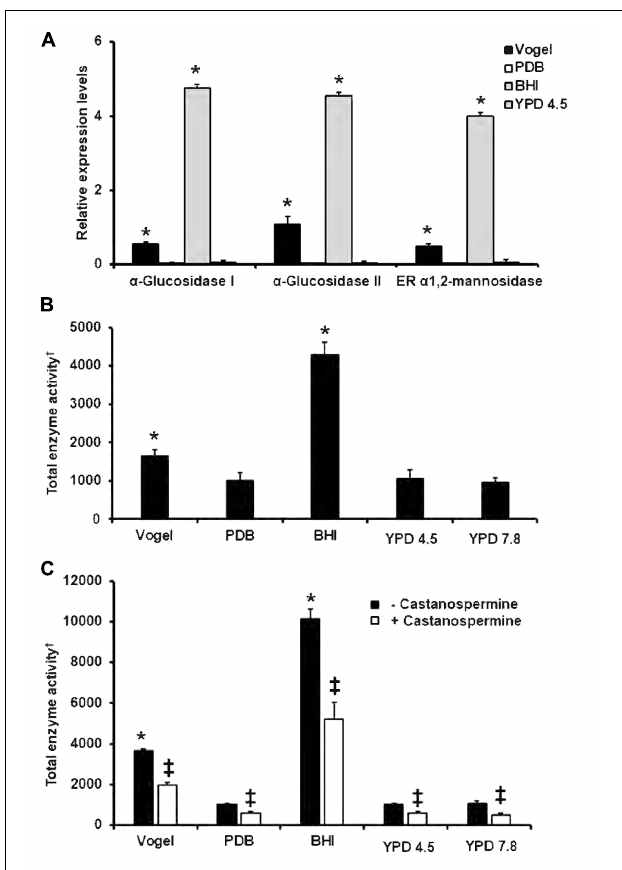
FIGURE 5 | Gene expression and enzyme activity of endoplasmic reticulum (ER) α -glycosidases in different culture media. In (A) , gene expression of ER glycosidases was determined and normalized using the gene encoding for the ribosomal protein L6 as control, and the fungal growth in YPD pH 7.8 as reference condition. In (B) , cells were grown in different culture media, mechanically broken, centrifuged to pellet cell debris and the cell homogenate used to quantify the total activity of α -mannosidase using the substrate 4-umbellipheryl- α - D -mannopyranoside. In (C) , cells were subjected to the same treatment as in (B) , but α -glucosidase activity using the substrate 4-umbellipheryl- α - D -glucopyranoside in absence or presence of 10 µ M castanospermine was determined. ∗ P < 0.05, when compared with untreated cells grown in YPD pH 7.8. ‡ P < 0.05, when compared with untreated cells. † Defined as nmoles of 4-methylumbellyferone min − 1 total protein − 1 .